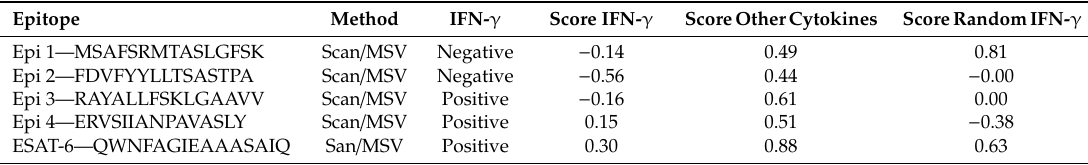
Table 4. Prediction of the four epitopes found and ESAT-6 epitope in the IFNepitope